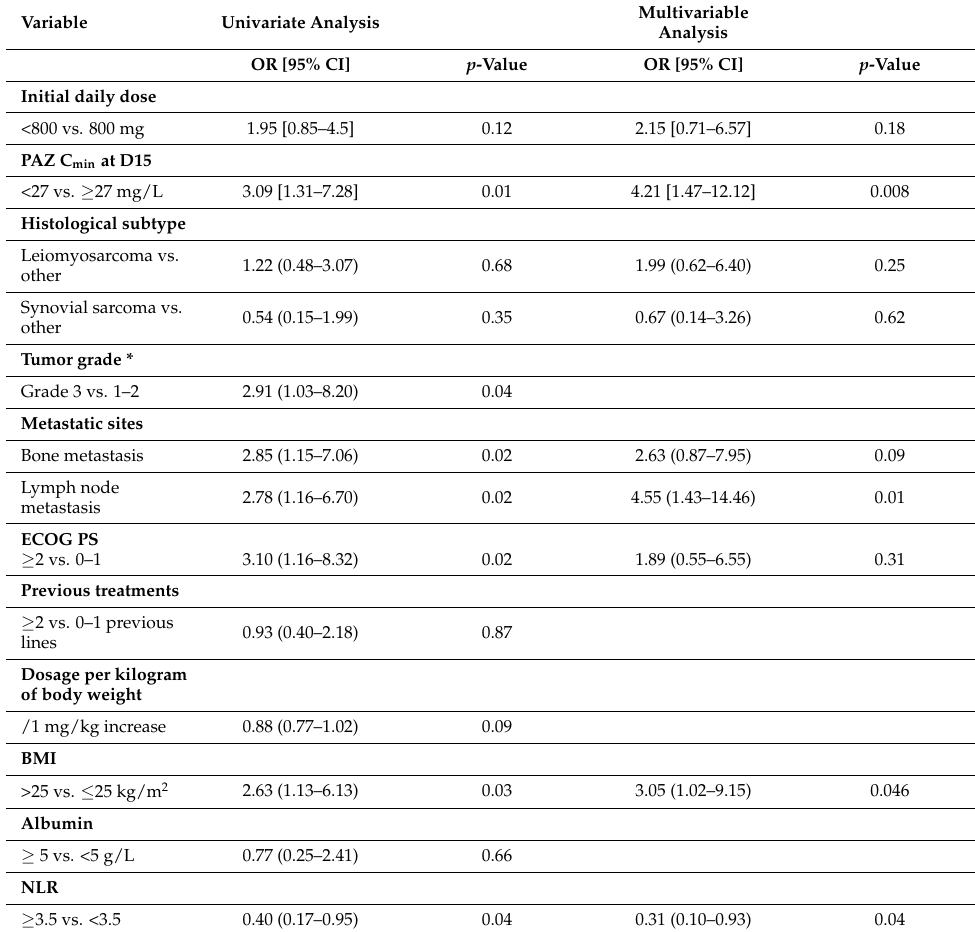
Table 2. Univariate and multivariable logistic regression models of risk factors for 3-month progres- sion (n =